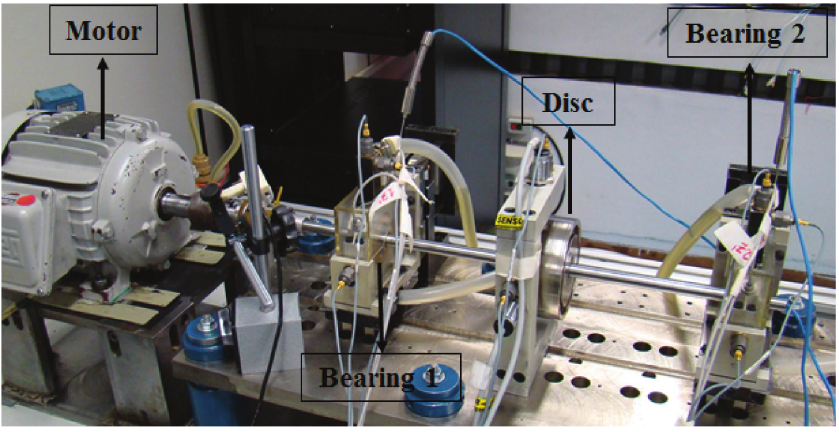
Figure 7 - Experimental test rig.